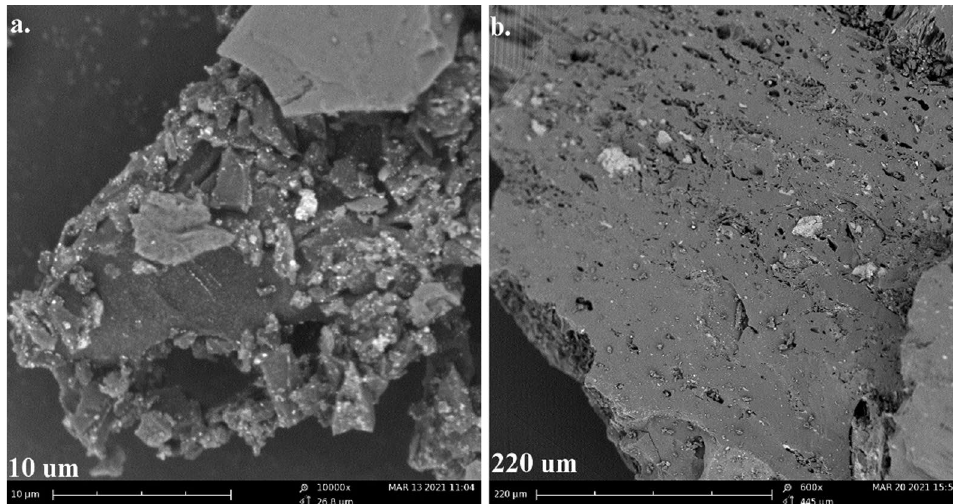
Fig. 2 Morphological arrangements of MCSB